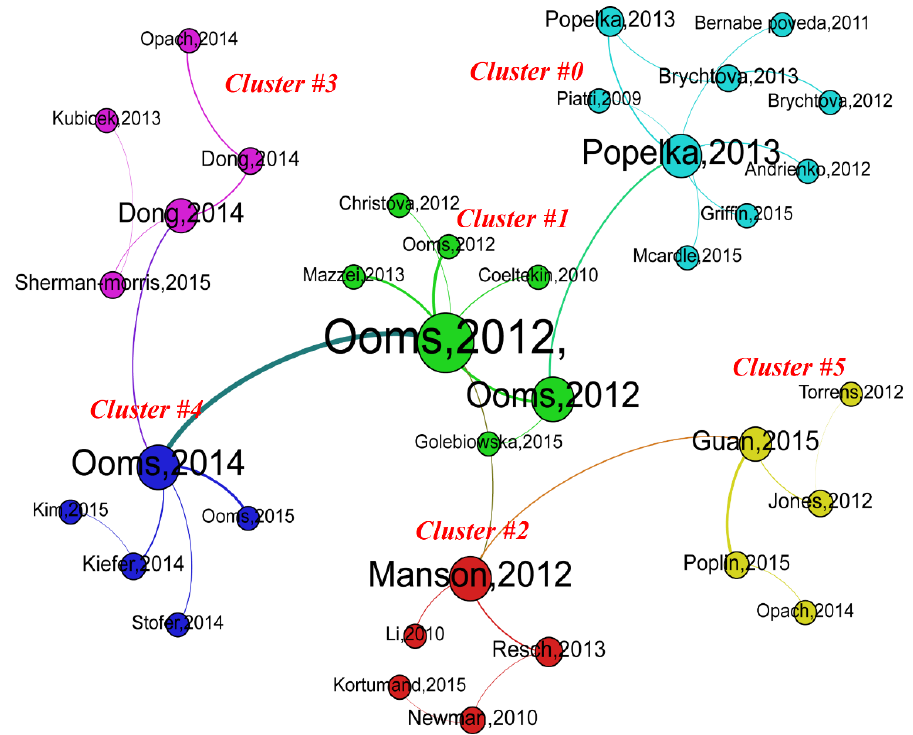
Figure 4. Clusters generated by bibliographic coupling analysis (size of the node represents its degree centrality in the network). Table 2. Labels for clusters generated by different term ranking algorithms.